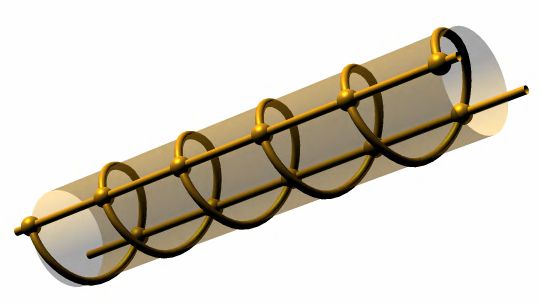
Observe that the curves of the form (87), being trajectories of a vector field ( Z , in this case), form a family of non–intersecting curves. But this property fails if to such a family we add also the curves (88), which in fact intersect all the curves (87). The points of intersection are precisely the points where C F fails to be 1–